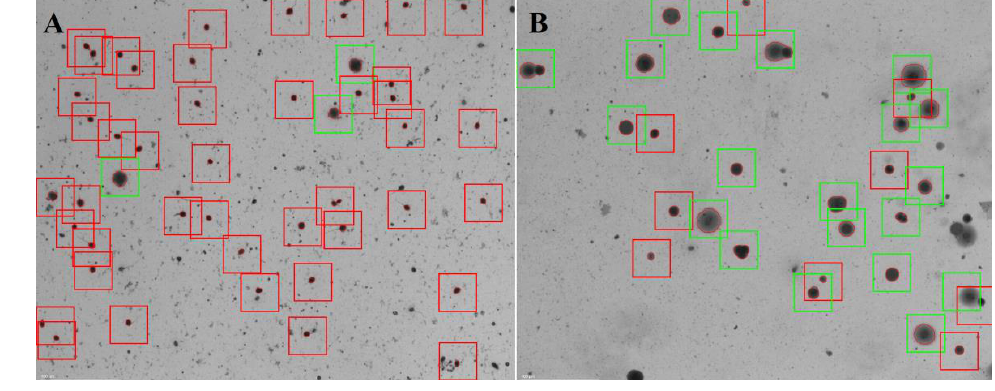
Figure 3. Demonstrative figure of sperm DF ( A ) before and ( B ) after magnetic-activated cell sorting. Cells were labelled based on the SCD method. Healthy cells show extended or moderate halos (green squares), while sperms with fragmented DNA show small or no halos (red squares).